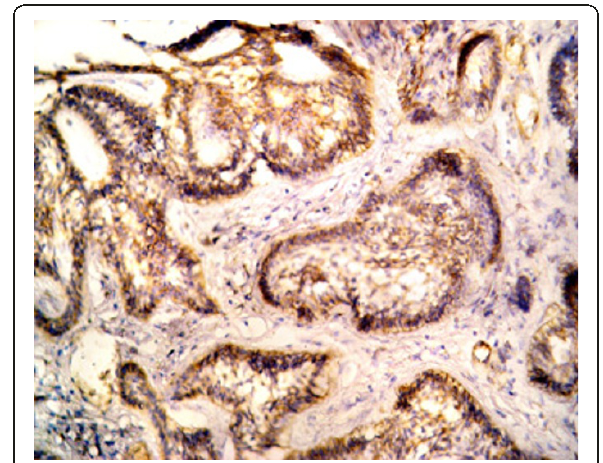
Figure 7 Photomicrograph of mural follicular variant of UCA showing cytoplasmic immunopositivity in ameloblast like cells & few stellate reticulum like cells. Note the peritumoral positive reaction (Anti-OPN. Original magnification x40)